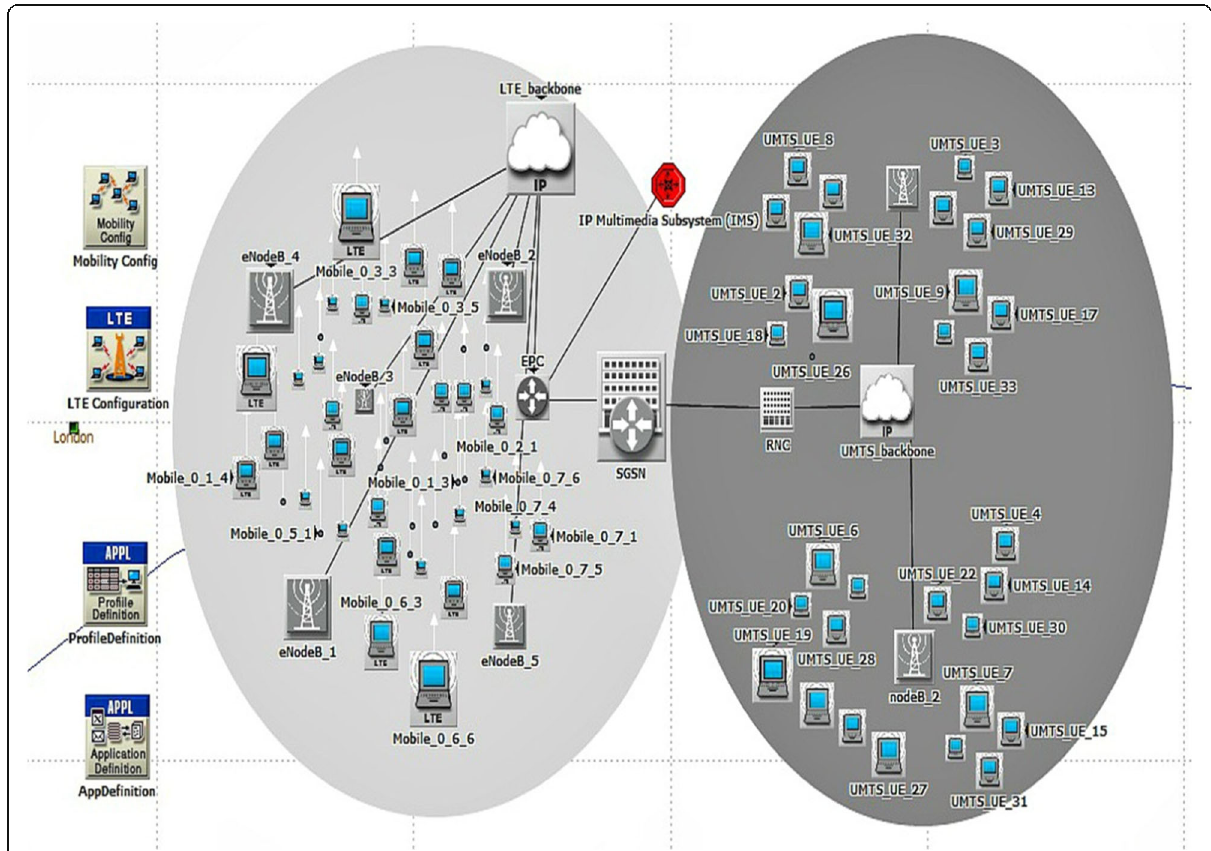
Fig. 6 Overview of the heterogeneous wireless network simulation model